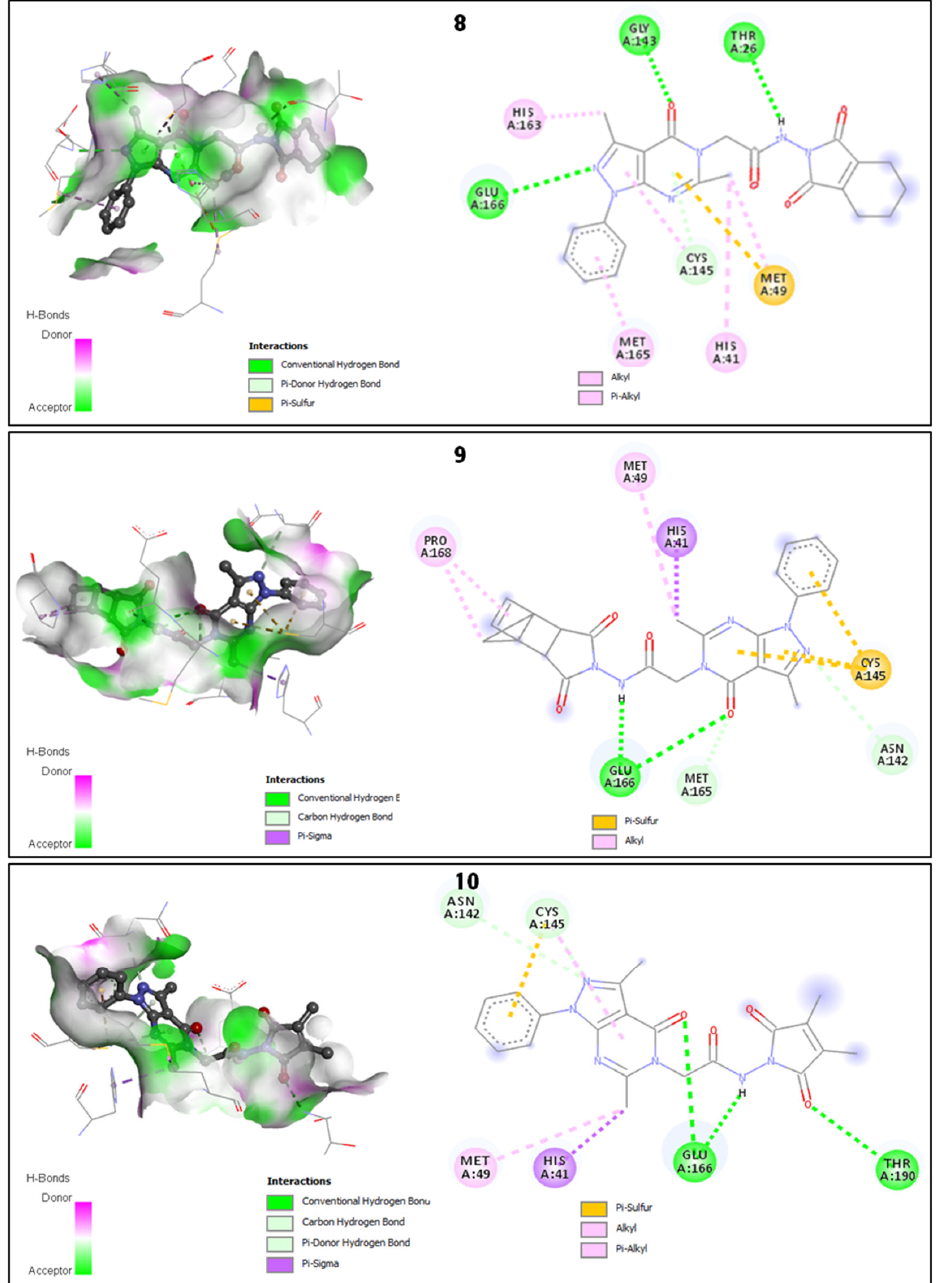
Figure 4. Representation of the 3D structure of the docked compounds 8 , 9, and 10 bound to the pocket region of SARS-CoV-2 M pro with the hydrogen bond ( left ) and the corresponding 2D diagram of the interactions ( right ).